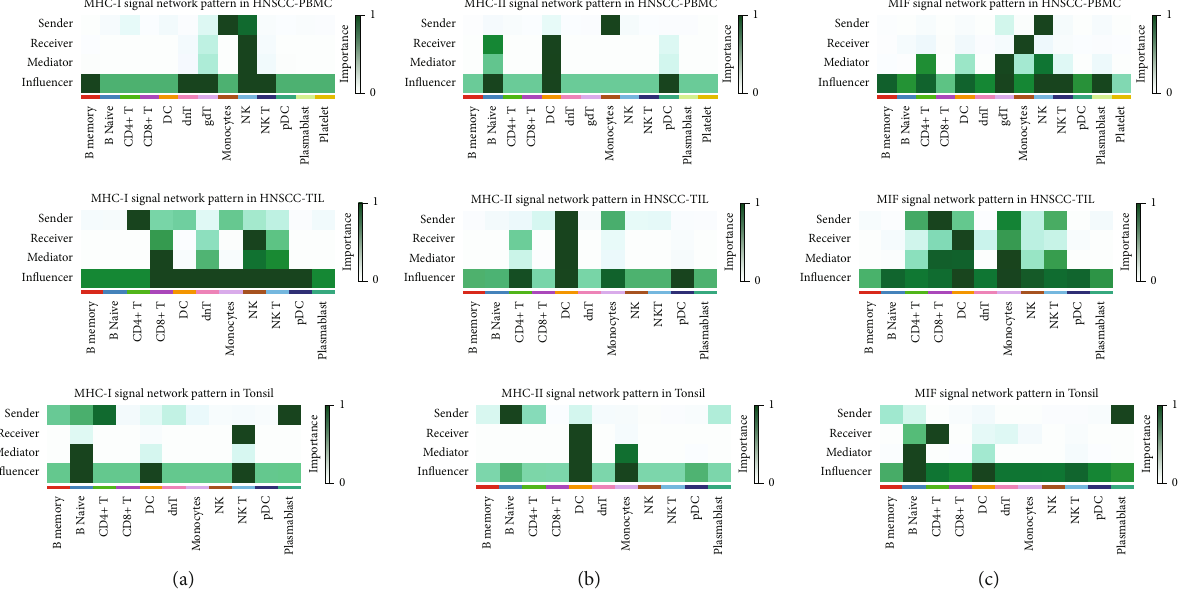
Figure 5: Identi fi cation of the main contribution signals of the cell group in the network. (a) MHC-I signal network pattern in HNSCC PBMC, TIL, and tonsil. (b) MHC-II signal network pattern in HNSCC PBMC, TIL, and tonsil. (c) MIF signal network pattern in HNSCC PBMC, TIL, and tonsil. The color in the heatmaps indicates the relative strength of the signal among cells. The horizontal axis is the cell type, and the vertical axis is the main contribution signals, including sender, receiver, mediator, and in fl uencer. Bars to the right correspond to signal